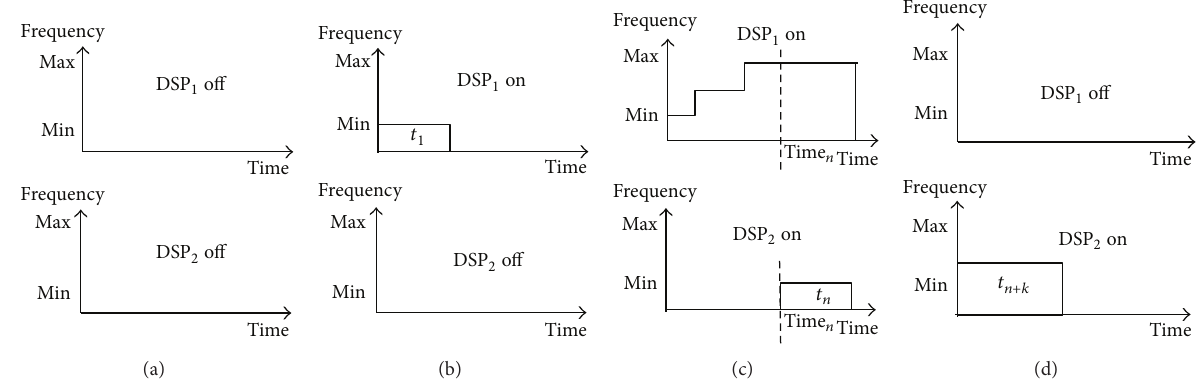
released while DSP 1 worked in full n